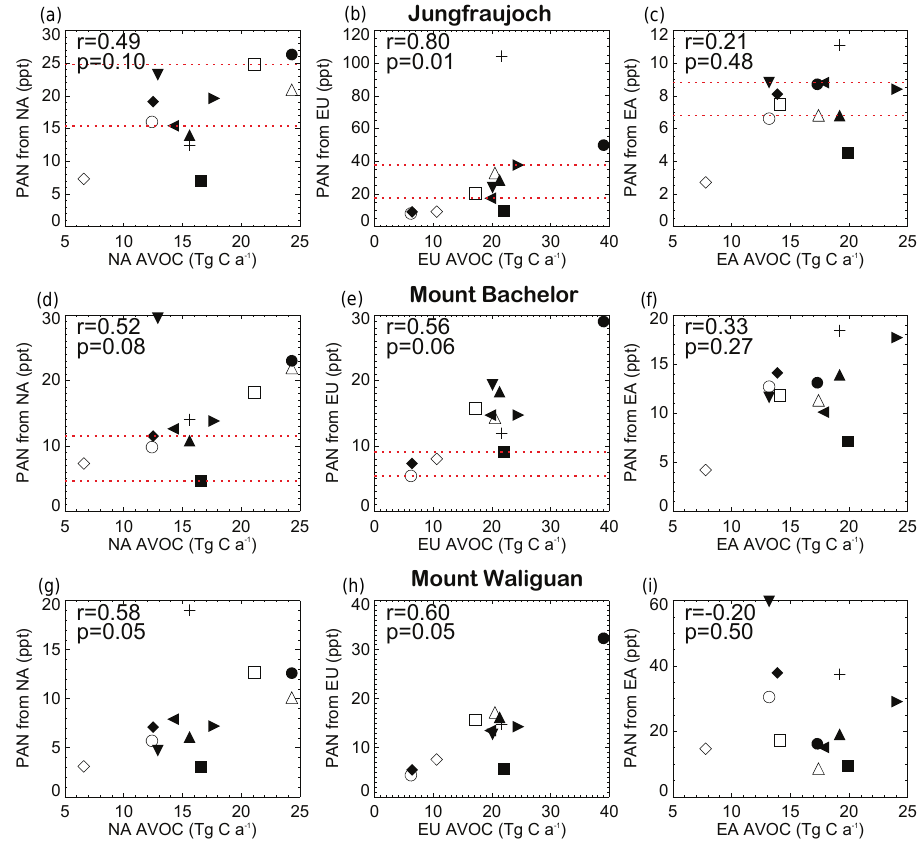
Figure 5. SRRs diagnosed as the difference between the SR1 and SR6xx simulations in Table 1 for PAN (ppt) at Jungfraujoch (a, b, c) , Mount Bachelor (d, e, f) , and Mount Waliguan (g, h, i) in each HTAP1 model (see Table 1 for the symbol assigned to each model) versus the annual emission of anthropogenic VOCs (AVOCs; TgCa − 1 ) within the NA (a, d, g) , EU (b, e, h) , and EA (c, f, i) source regions. The Spearman’s rank correlation coefficient (more robust to outliers than the traditional Pearson coefficient) and associated p value are shown in each panel. The horizontal red lines correspond to the values identified with the red symbols in Fig.